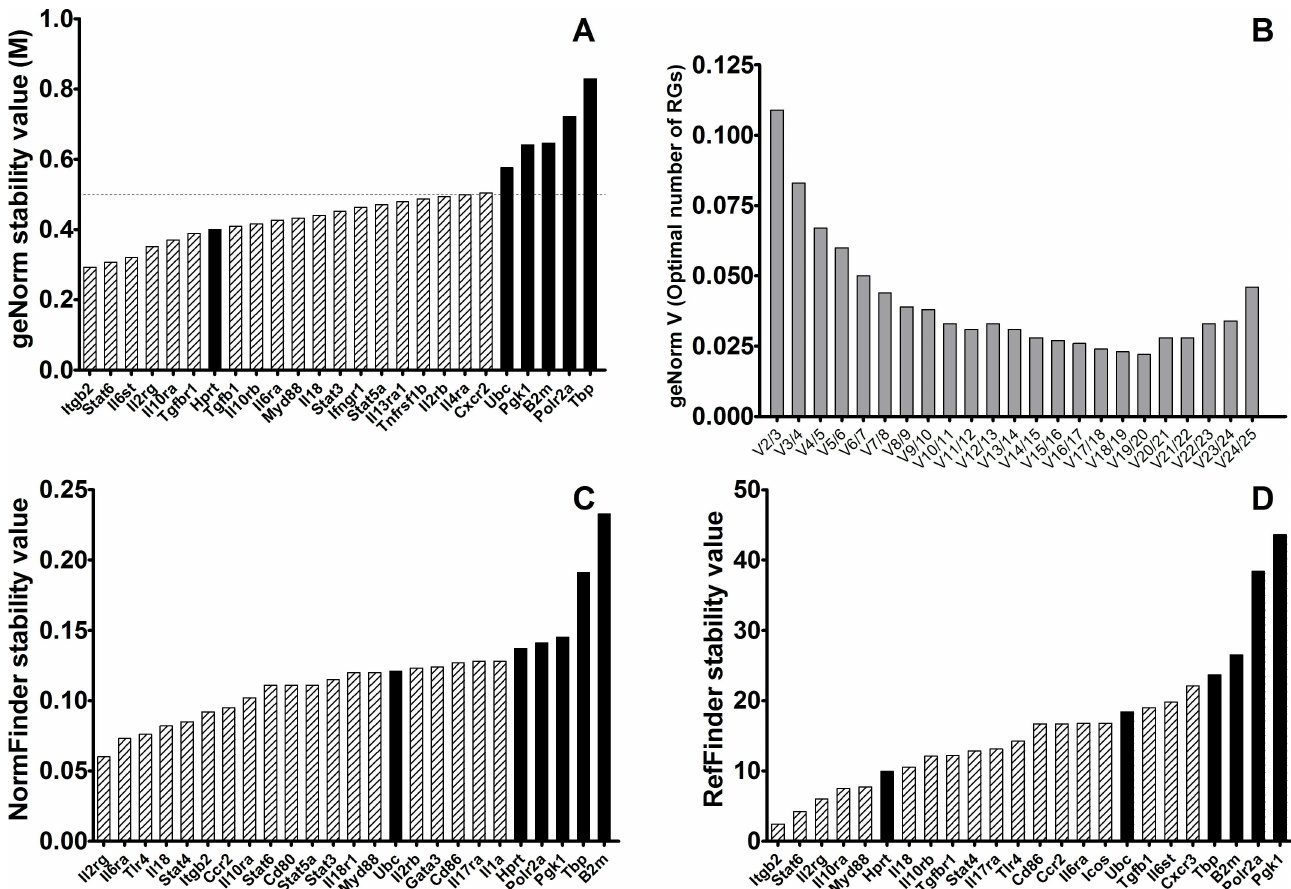
Fig 3. Stability values of the best candidatereferencegenes(lightgray) and 6 six classicalreference genes(black bars) in spleensamples of bothgroups of mice (controland Leishmania -infected BALB/c mice).A) M-stabilityvalue accordingto geNorm;horizontalline marksthe